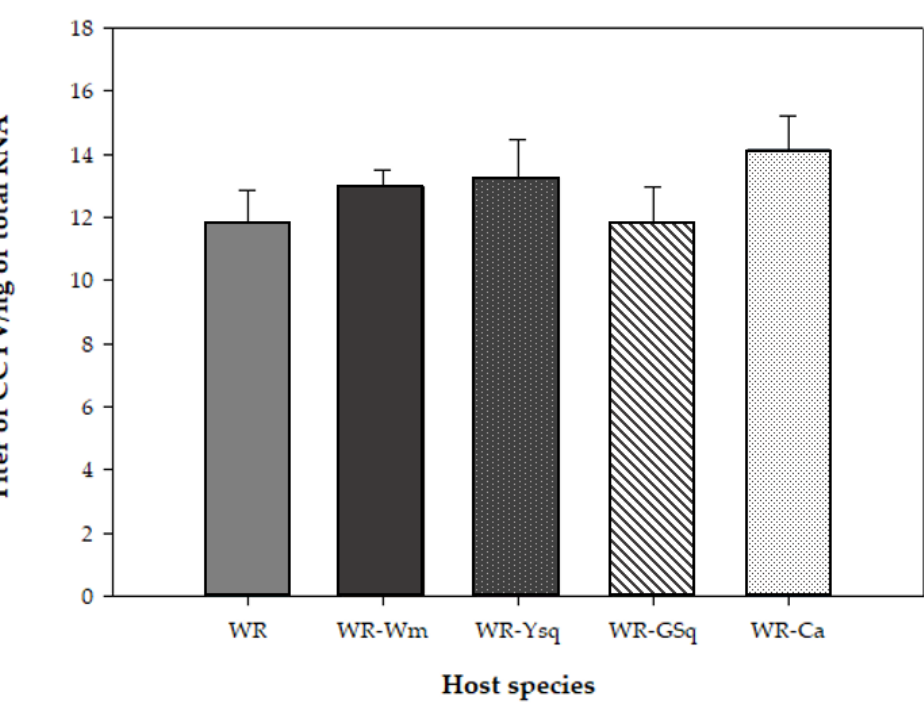
Figure 4. Estimate of cucurbit chlorotic yellows virus (CCYV) titer in wild radish (WR) and cucurbits hosts after back transmission from wild radish (WR-Wm: Watermelon, WR-Ysq: yellow squash, WR-GSq: green squash, WR-Ca: cantaloupe) by reverse transcriptase-quantitative polymerase chain reaction (RT-qPCR) using primers detailed in Table 1. Data points represent the mean estimated copy numbers of CCYV from five different plants of each species. Each plant was replicated three times. Bars indicate the standard error of the mean.